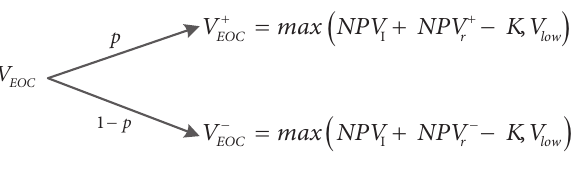
Figure 2. Option model of EOC in PPP projects